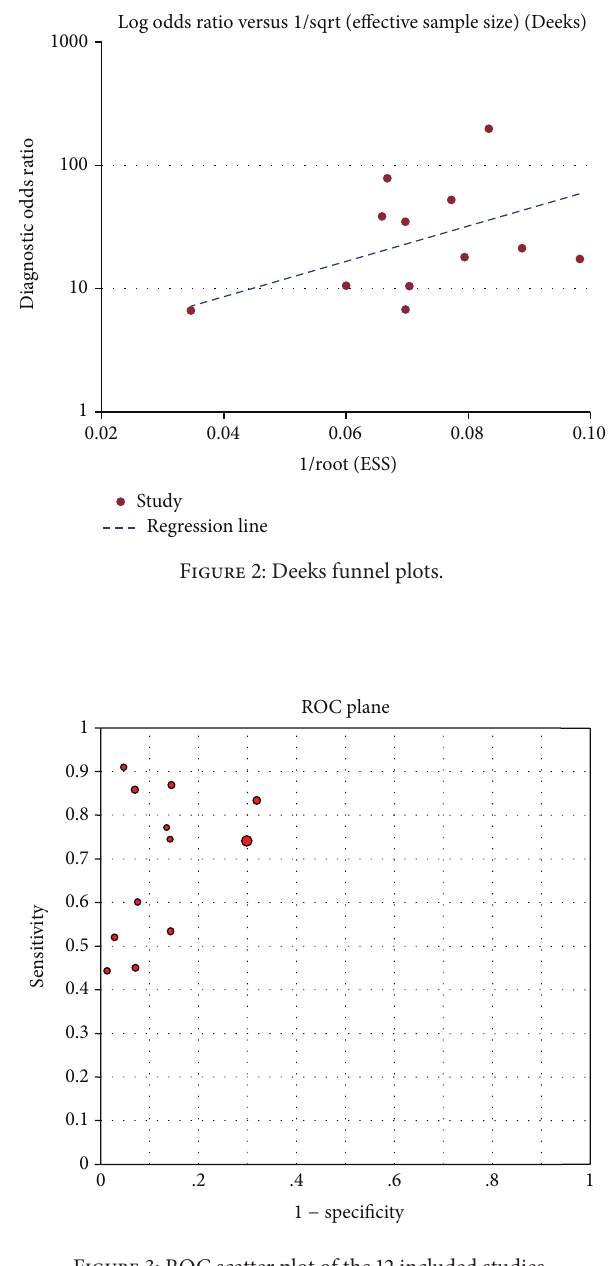
Figure 3: ROC scatter plot of the 12 included studies.